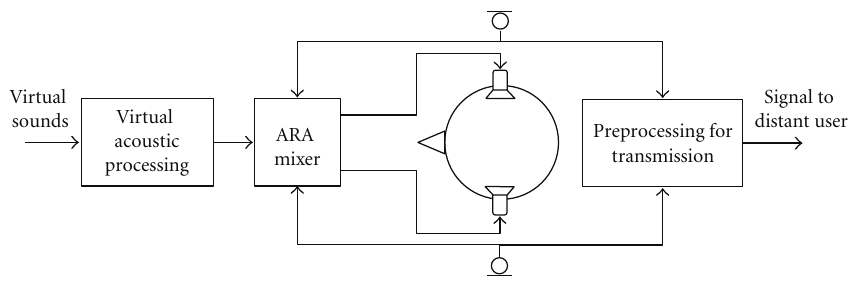
Figure 1: Block diagram of an ARA